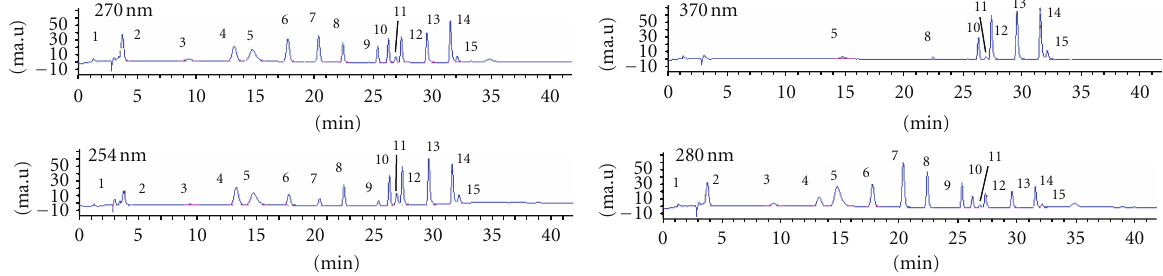
Figure 2: HPLC chromatogram of antioxidant standards. ∗ 1: fumaric acid; 2: gallic acid; 3: catechins; 4: vanillic acid; 5: ca ff eic + chlorogenic acid; 6: syringic acid; 7: p-coumaric acid; 8: ferulic; 9: naringin; 10: rutin; 11: ellagic; 12: myricetin; 13: quercetin; 14: kaempferol; 15: